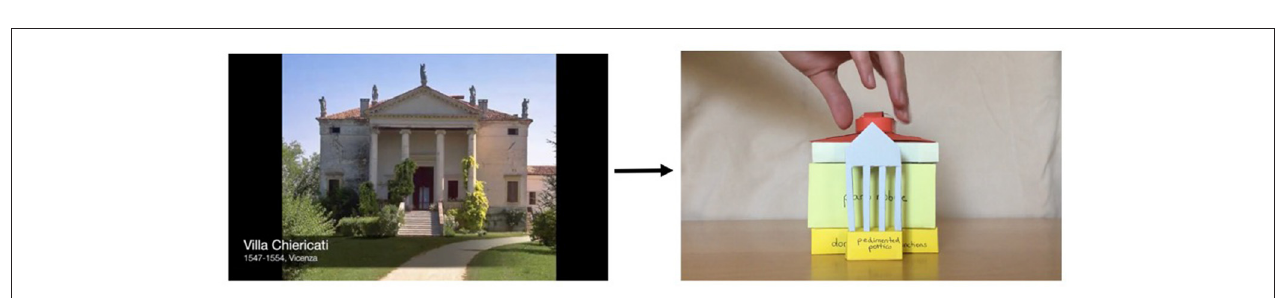
FIGURE 11 | Transducing a photographic image to Model 1.